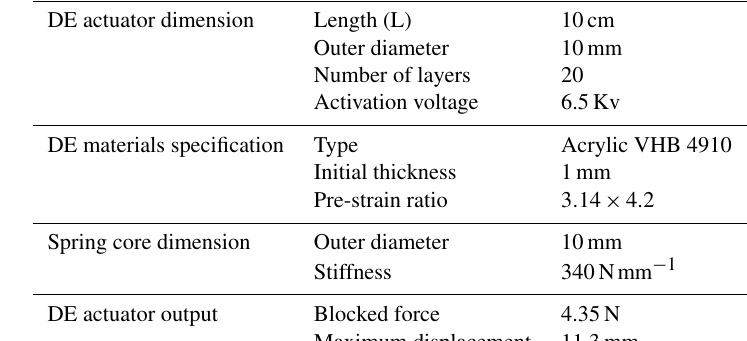
Table 6. The constructional parameters of the spring roll DE actuator.